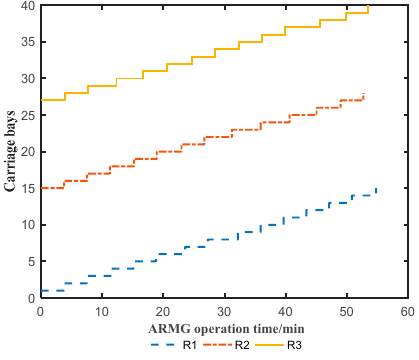
Figure 9. Path to the ARMGs. Table 6. Scheduling results for AGVs.